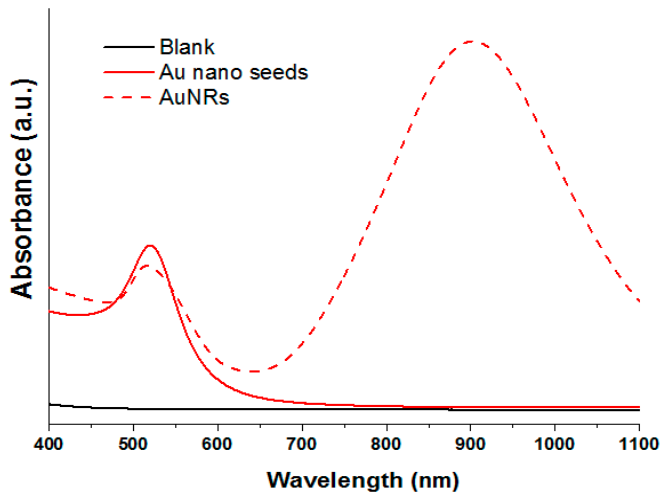
Figure 3. Ultra-violet -Visible (UV-Vis) spectra of Au nanoseeds and AuNRs.